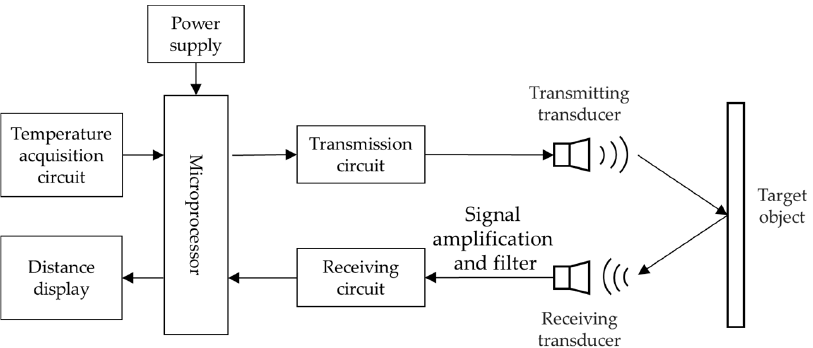
Figure 5. An overall diagram of ultrasonic ranging system.